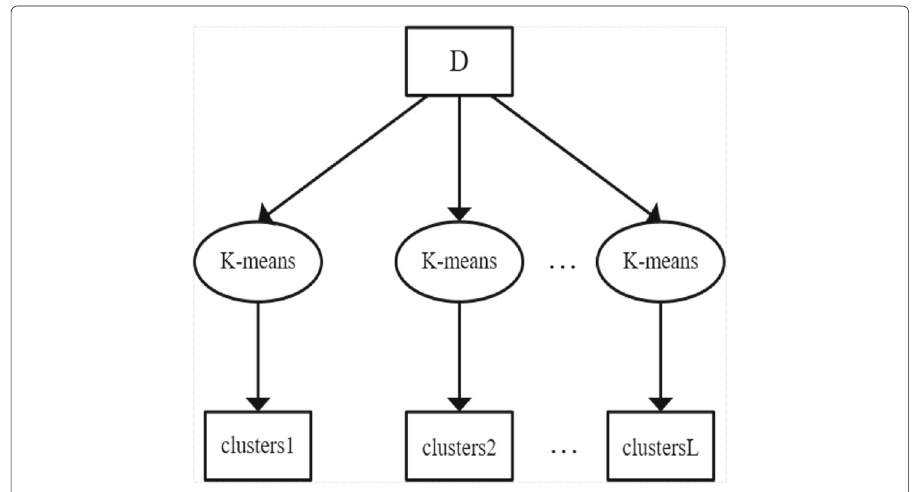
Fig. 1 Stepwise procedure of SMLC. A flow set D containing only normal flow is used to construct the normal flow model, and the flow in D is multi-layer clustered